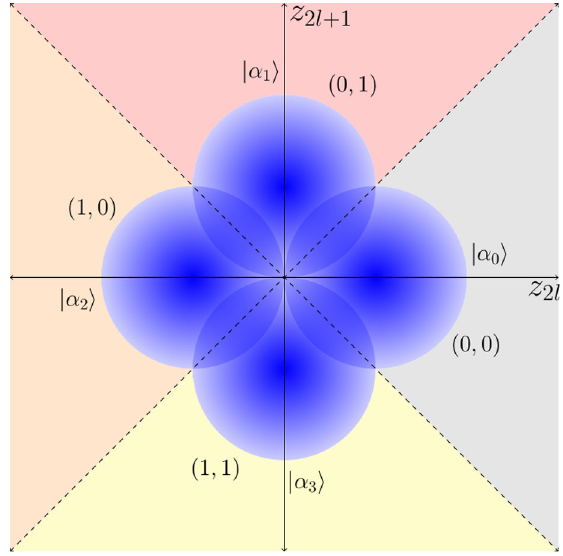
FIG. 1. Description of the QPSK protocol with a constellation of four coherent states and the partition of phase space in four